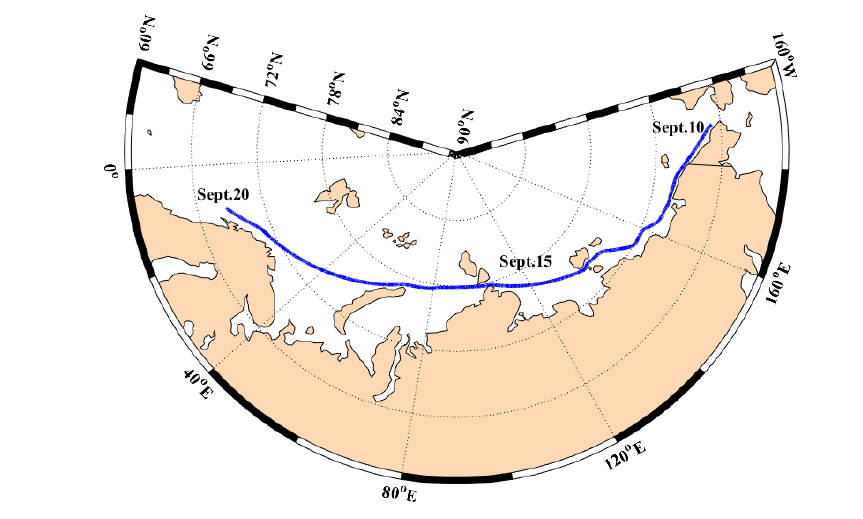
Figure 3. Journey of M/V TIANHUI in NEP from 10 September to 20 September